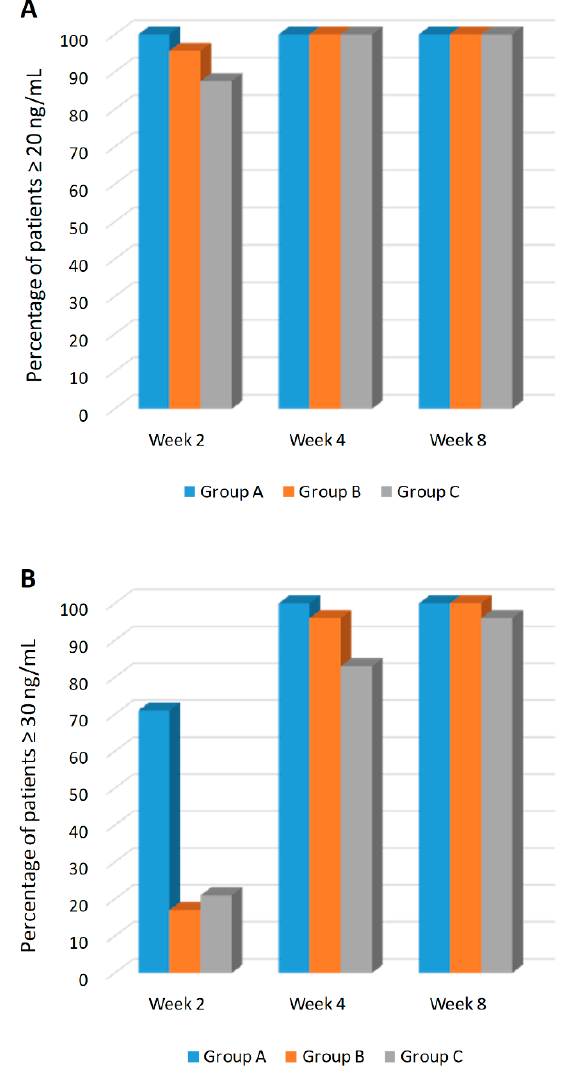
Figure 3. Percentage of patients achieving the 20 ng / mL ( A ) and 30 ng / mL threshold ( B ) at weeks 2, 4, and 8. Group A; 10,000 IU daily, Group B; 50,000 IU weekly and Group C; 100,000 IU bi-weekly doses of cholecalciferol.